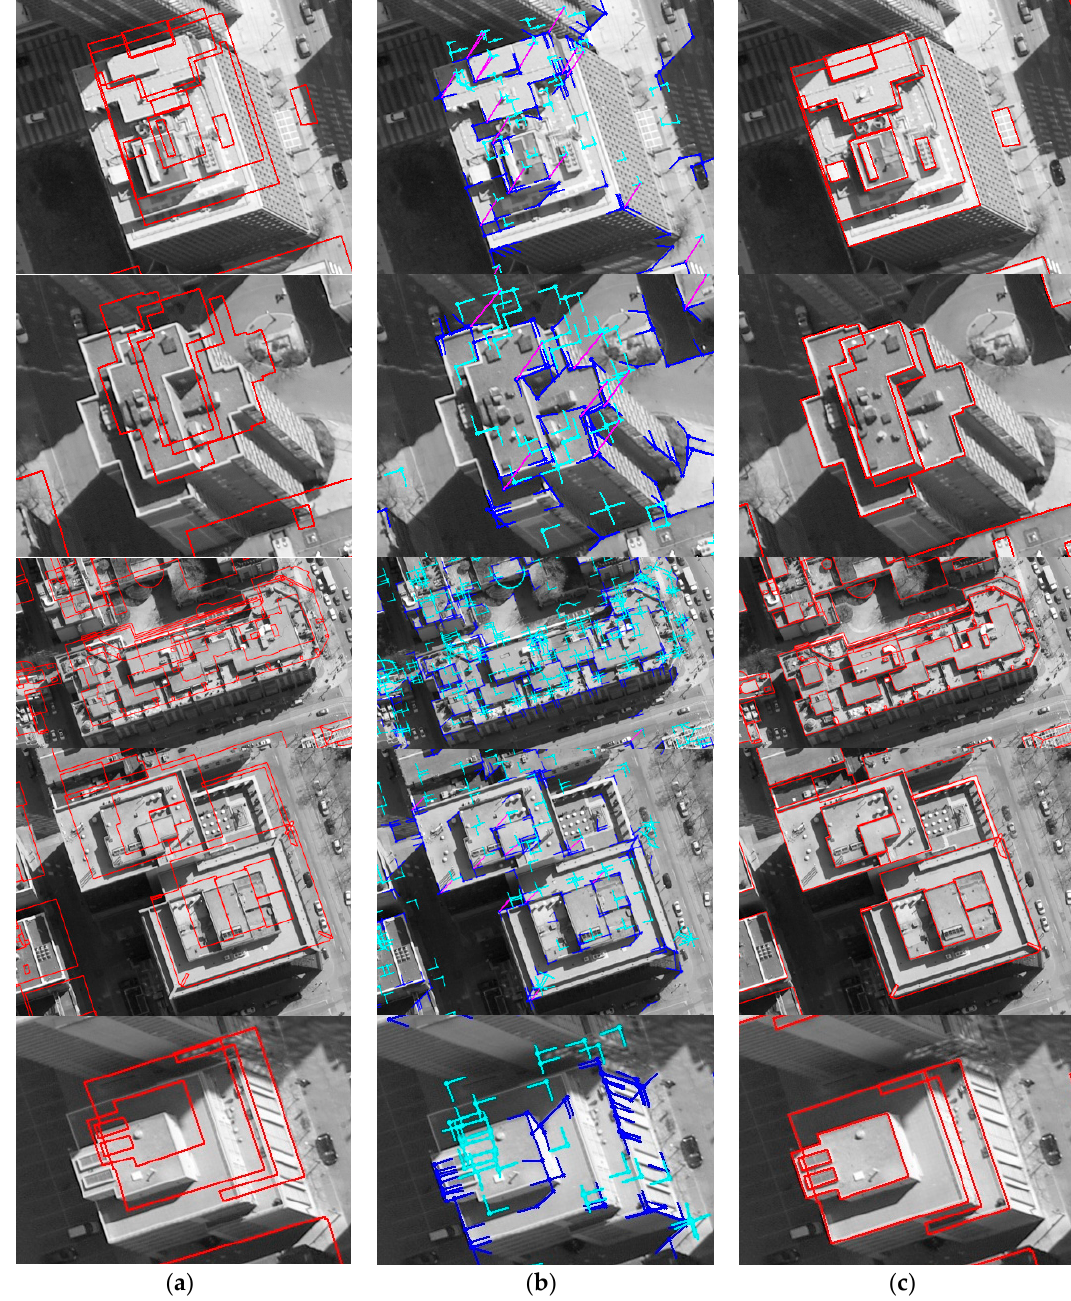
Figure 11. Manually digitized building models: ( a ) with error-contained EOPs; ( b ) matching relations (purple) between edged corner features extracted from the image (blue) and from the models (cyan), and ( c ) with refined EOPs.